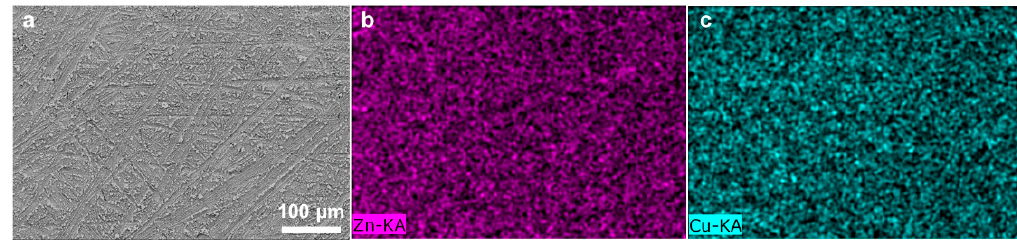
Figure 2. ( a ) SEM image and ( b , c ) the corresponding elemental mappings of Cu–Zn.